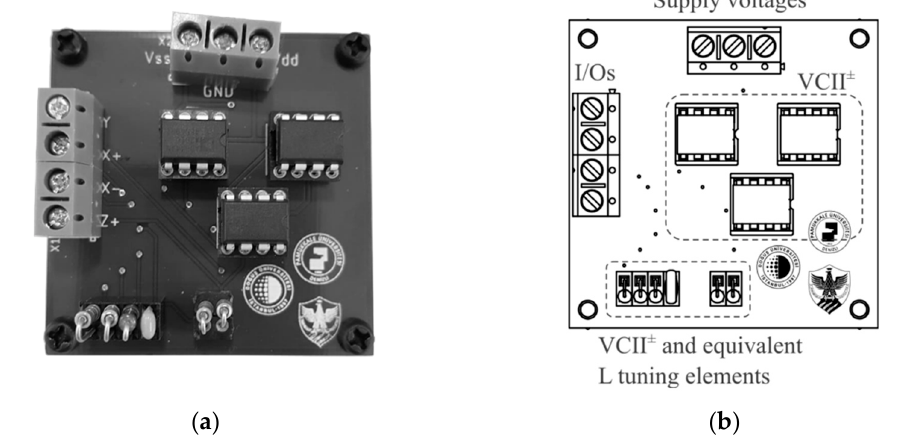
Figure 17. A photograph of the fabricated board ( a ) and its description ( b ).